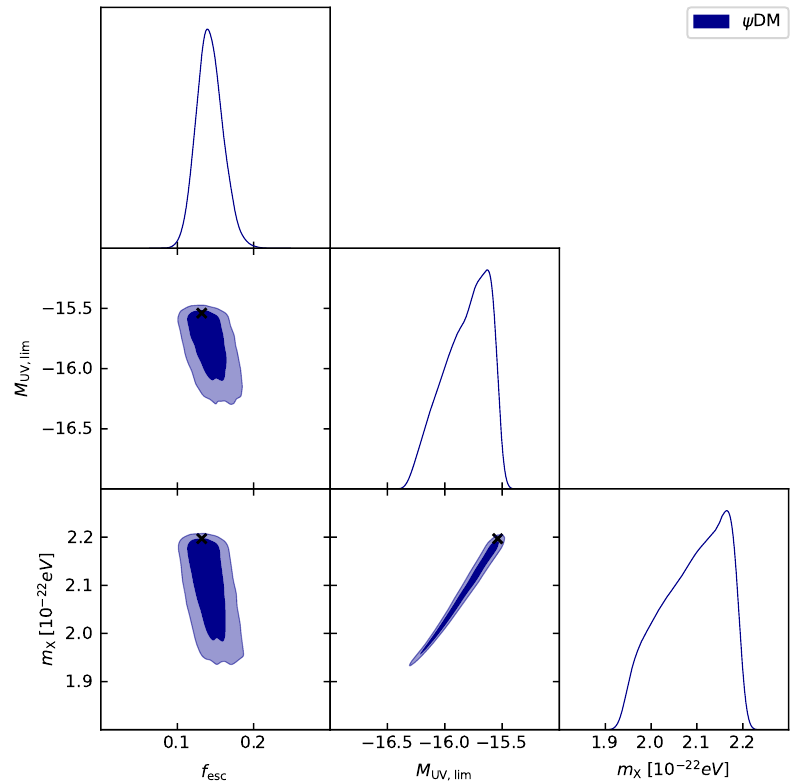
Figure 7. MCMC posterior distributions in the ψ DM scenario (blue contours/lines), for the escape fraction f esc of ionizing photons, the limiting UV magnitude M UV,lim , and particle mass m X . The con- tours show 68% and 95% confidence intervals, the black cross shows the maximum likelihood position, and the marginalized distributions are in arbitrary units (normalized to 1 at their maximum